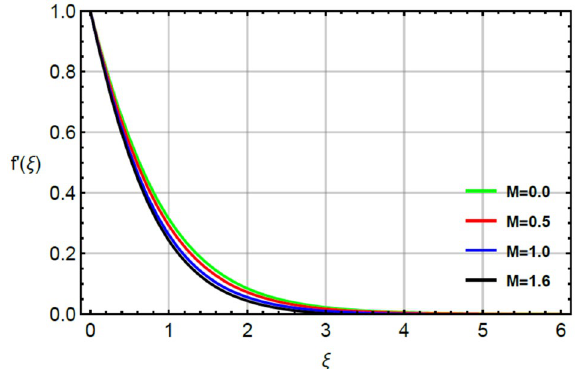
Figure 2. Character of M on f ′ .